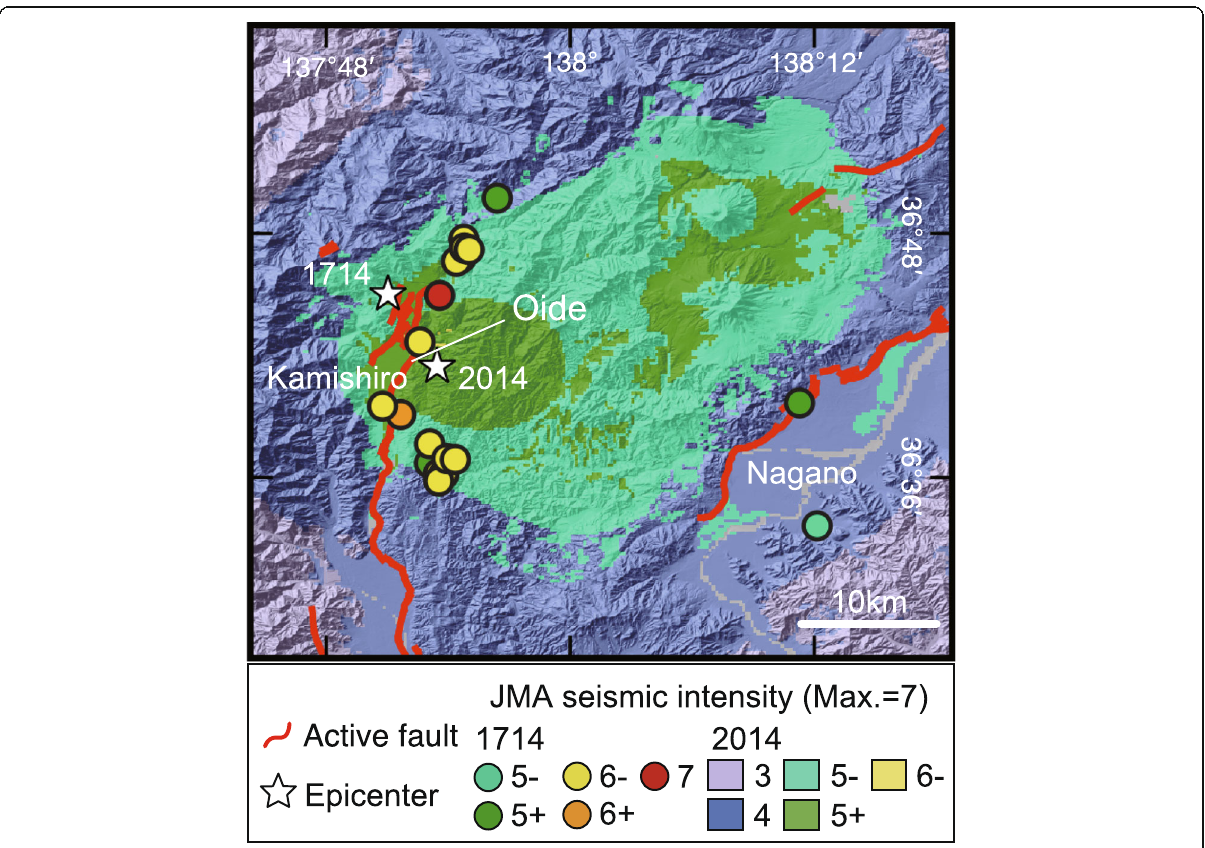
Fig. 2 Seismic intensity of the 1714 and the 2014 earthquake. Intensity is shown in Japan Meteorological Agency scale (0 – 7). The intensity and the epicenter of the 1714 event were from Tsuji (2003), and those of the 2014 earthquake were from the Geological Survey of Japan (2014). Error of the 1714 epicenter was within a 25 km